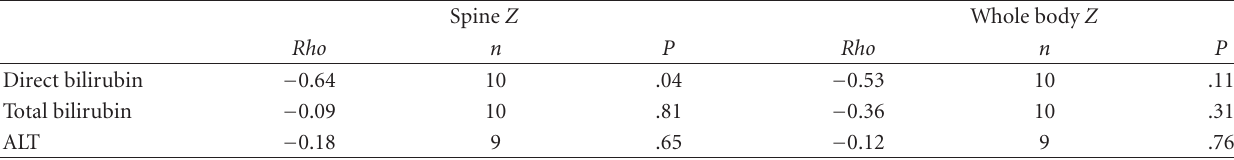
Table 3: Spearman correlation of bone mineral content and serologic tests.